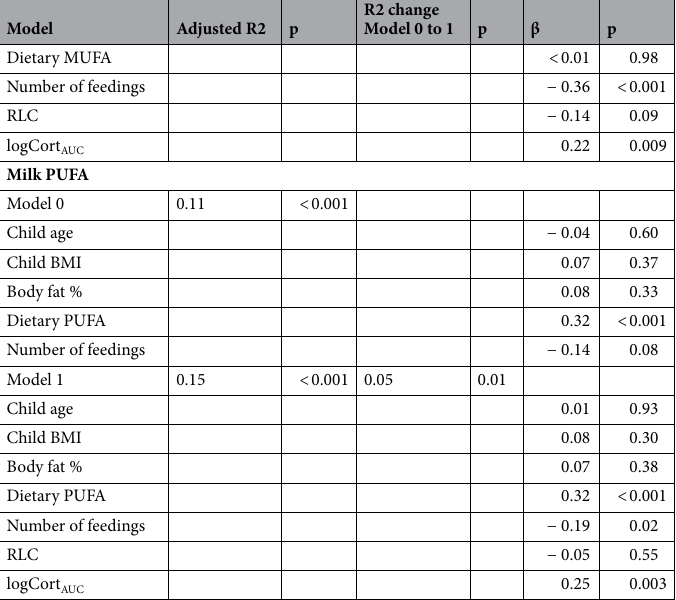
Table 6. Maternal stress (RLC), cortisol level, and number of feedings predict fatty acid levels in breast milk. Significant associations (p < 0.05) between maternal stress and cortisol levels were found for concentrations of milk MCFA , LCFA, LCFA-S, MUFA, and